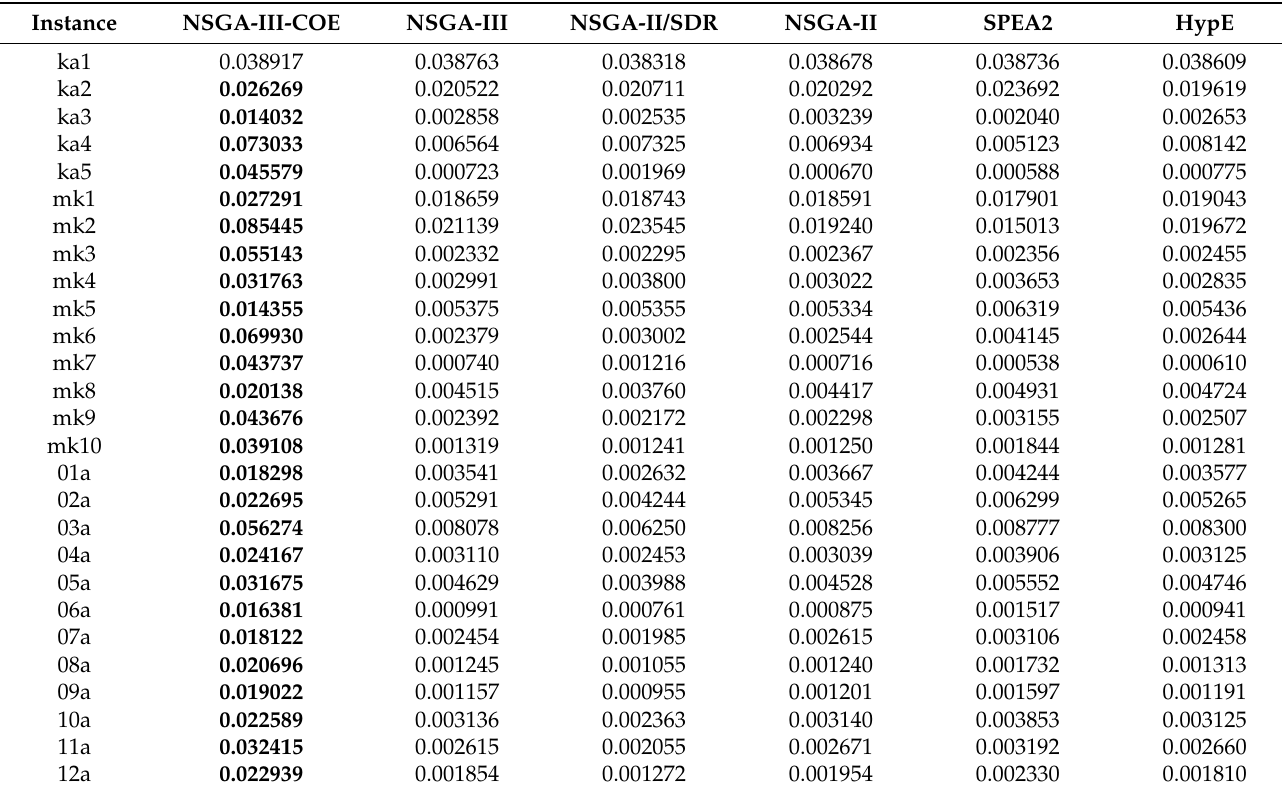
Table 6. Performance evaluation of the NSGA-III-COE and other comparison algorithms; the average HVs of 27 problem instances running 30 times independently. For each instance, the results which are significantly better than the others are marked in bold (these have much larger HV value than the other